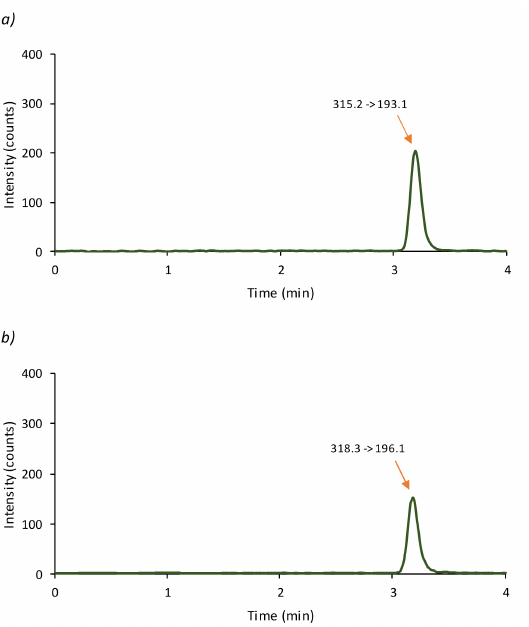
Figure 3. Chromatogram obtained applying the proposed LC-MS/MS method to a cosmetic cream (sample C) (( a ) CBD; ( b )